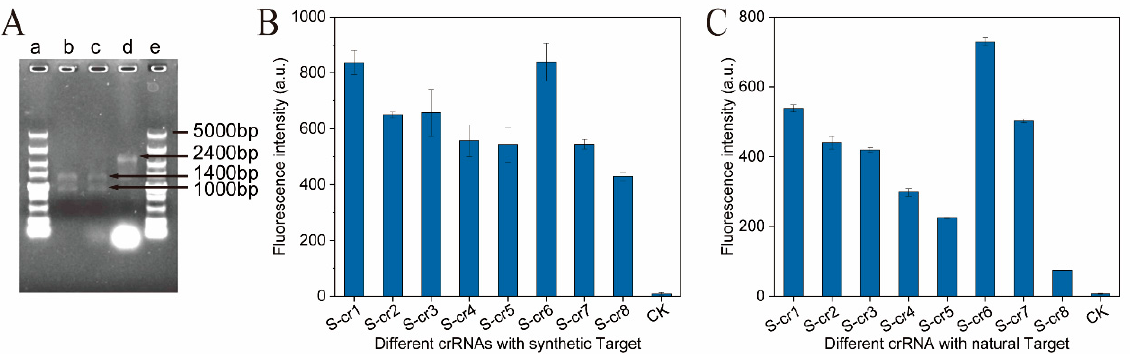
Figure 2. Cas12a trans-cleavage activity verification and a CRISPR-Cas12a fluorescence reporting system for Lactobacillus panis . ( A ) Cas12a activity verification. Lanes a and e are 5000 bp markers; lanes b and c are cleavage products (indicated by arrows) with sequence lengths of the target DNA fragments, Cas12a, and the ssDNA probe with different crRNAs; and lane d is the target DNA, ssDNA probe, and crRNA without Cas12a. ( B ) The fluorescence intensity of different crRNAs with a 50 bp synthetic 16S rDNA fragment of L. panis . ( C ) The fluorescence intensity of different crRNAs with 1.5 kb 16S rDNA amplified by colony PCR using an L. panis colony as a template.